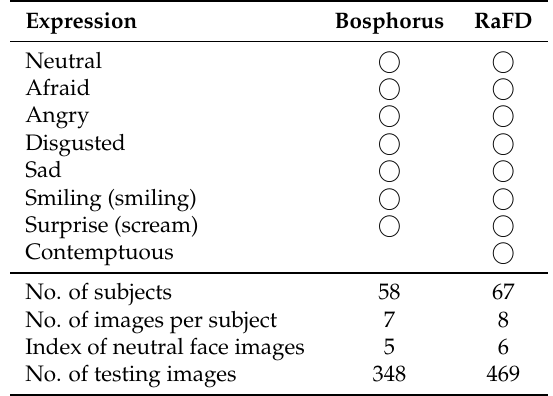
Table 1. Characteristics of each facial expression